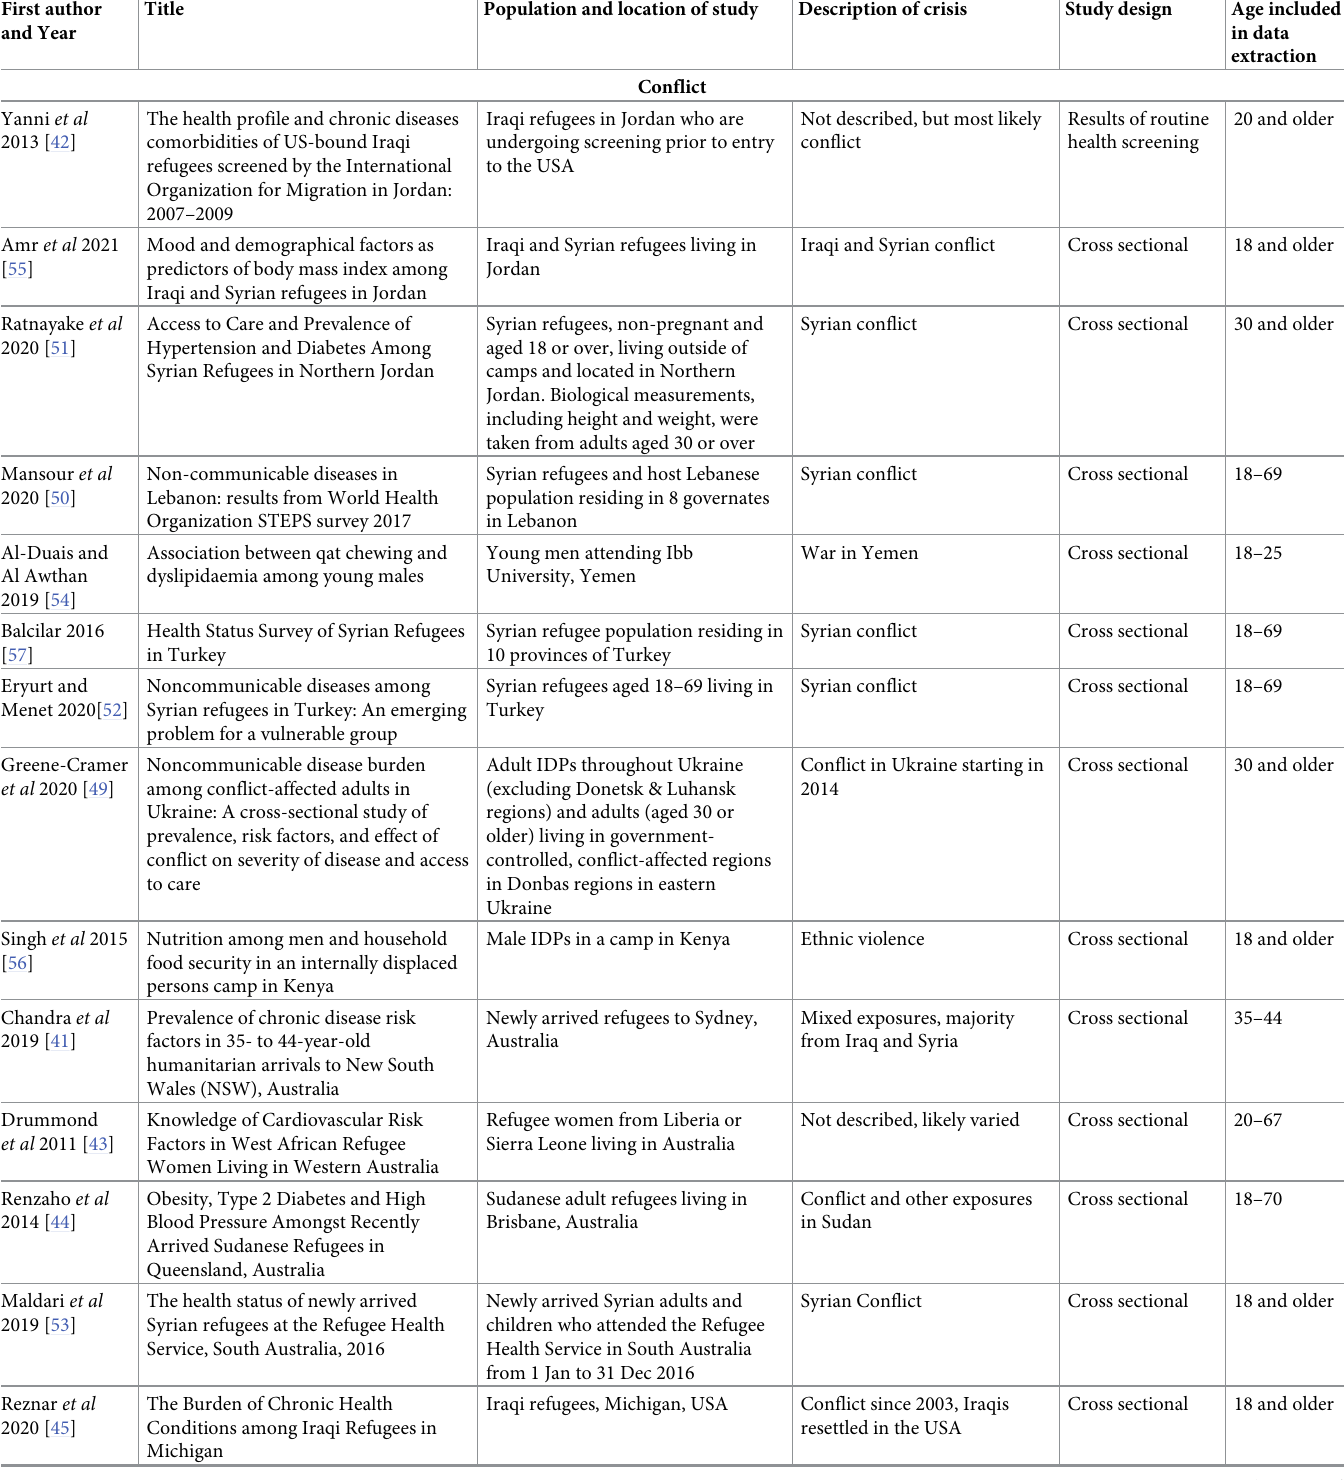
Table 1. Showing characteristics of included